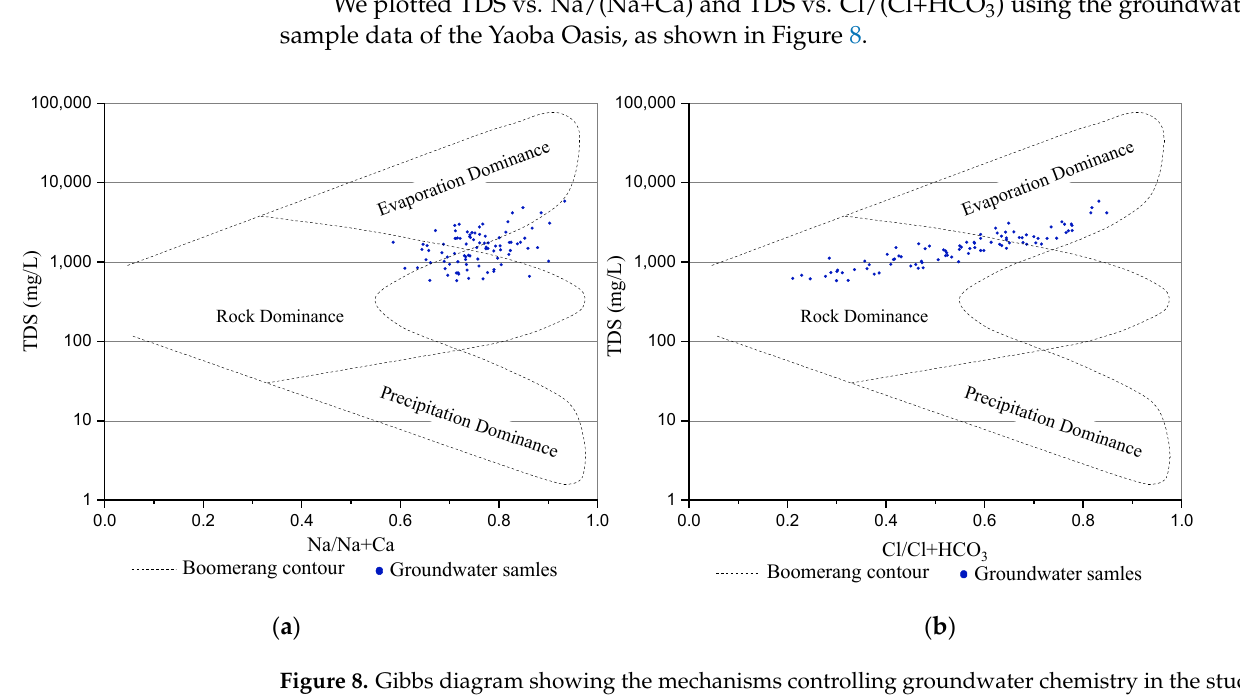
high concentration of TDS, and Cl/(Cl+HCO 3 ) ratio rose correspondingly above 0.6 (Figure